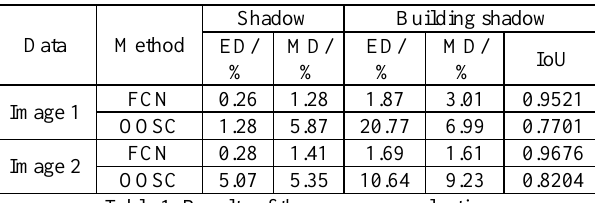
Table 1. Results of the accuracy evaluation *FCN: Fully convolutional network OOSE: Object-oriented supervised classification ED: Error detection